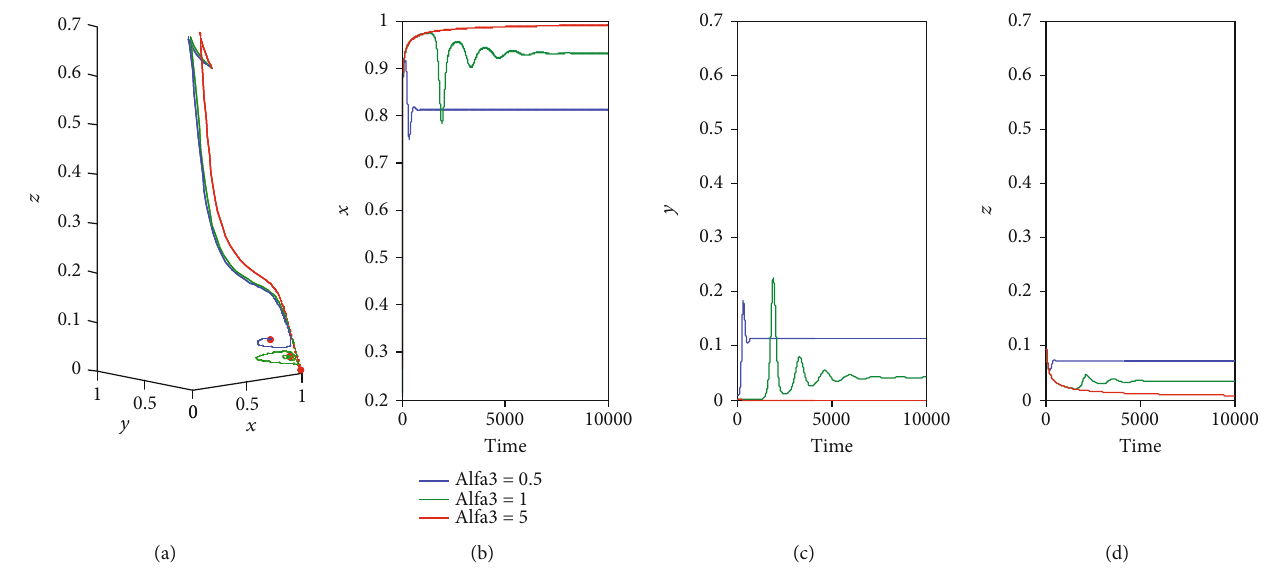
= 0 : 5, 1, and5 represented by the 3